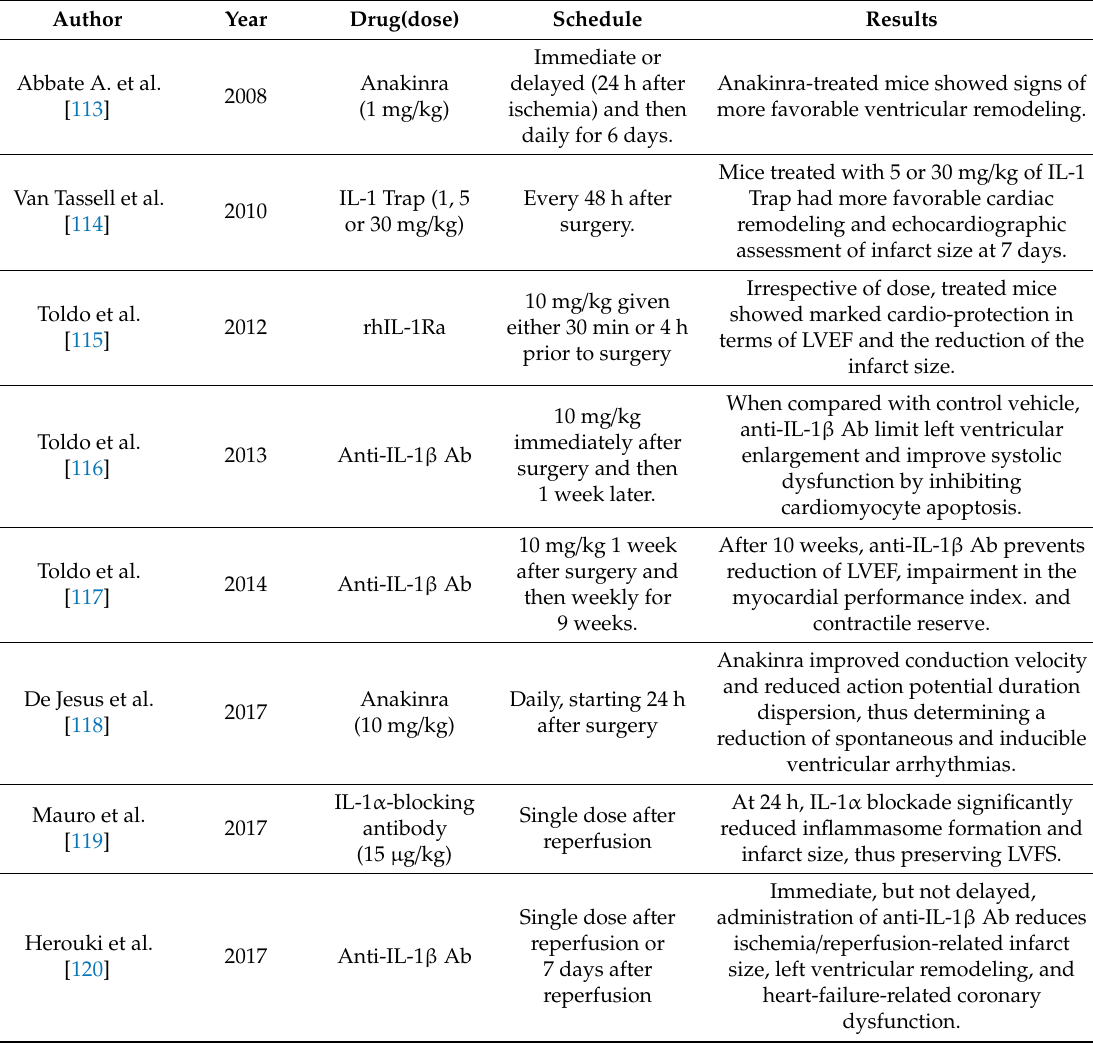
Table 1. Experimental studies investigating the e ff ect of IL-1 inhibition in preventing cardiac remodeling after myocardial